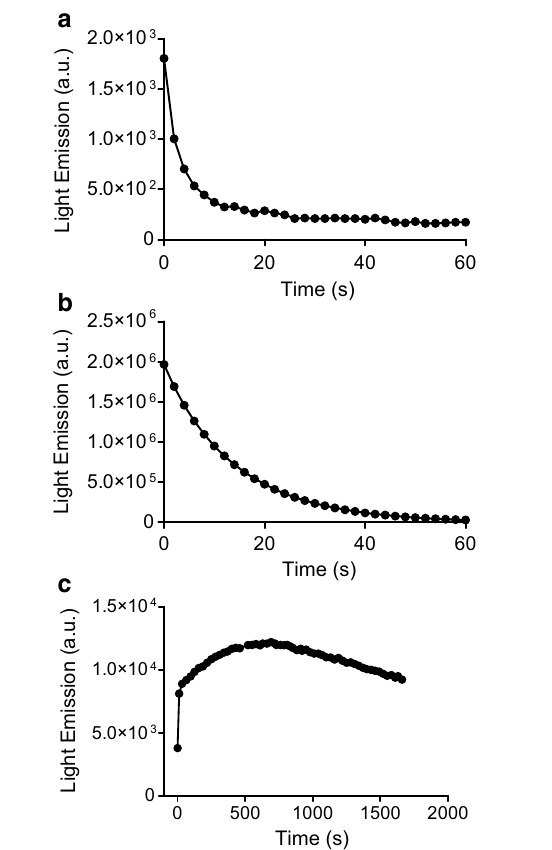
Fig. 2 Light emission generated by the production of singlet oxygen. a HOCl and H 2 O 2 ; b HOCl, H 2 O 2 and melatonin; c NCT, H 2 O 2 and melatonin. Reaction condition: HOCl and NCT 1 mM, melatonin